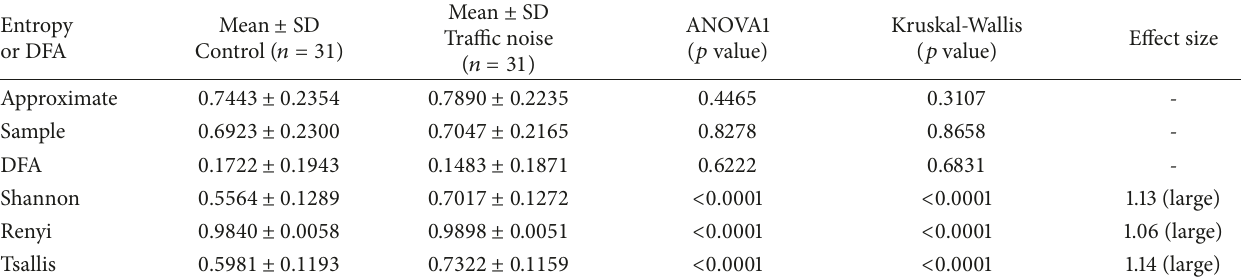
Table 7: Entropic measures for the control and traffic nose exposure subjects RR intervals.